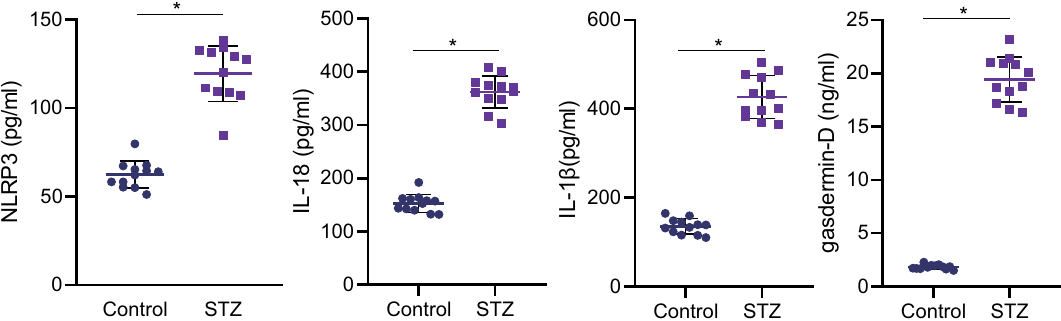
12. * p < 0.05. Data are shown =